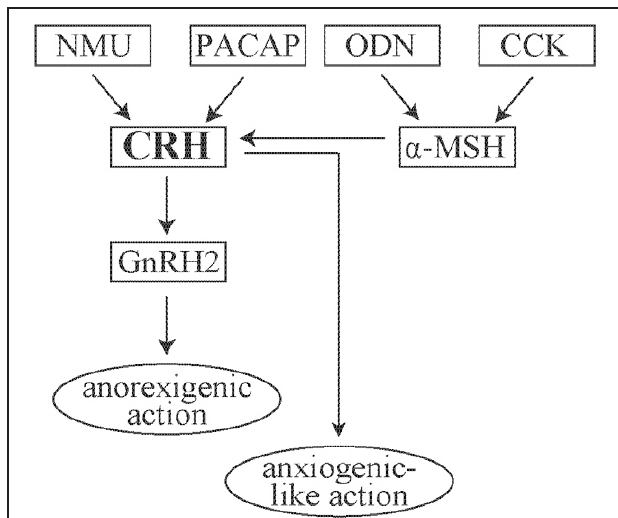
FIGURE 1 | Schematic drawings of the neuronal signaling pathways of anorexigenic and anxiogenic-like action in goldfish. ODN and CCK-induced anorexigenic actions are mediated by α -MSH-signaling pathway, and the anorexigenic actions of NMU, PACAP, and α -MSH are mediated by CRH- and subsequent GnRH2-signaling pathways. CRH also evokes anxiogenic-like action. Abbreviations: NMU, neuromedin U; PACAP, pituitary adenylate cyclase-activating polypeptide; ODN, octadecaneuropeptide; CCK, cholecystokinin; CRH, corticotropin-releasing hormone; α -MSH, α -melanocyte-stimulating hormone; GnRH2, gonadotropin-releasing hormone 2.